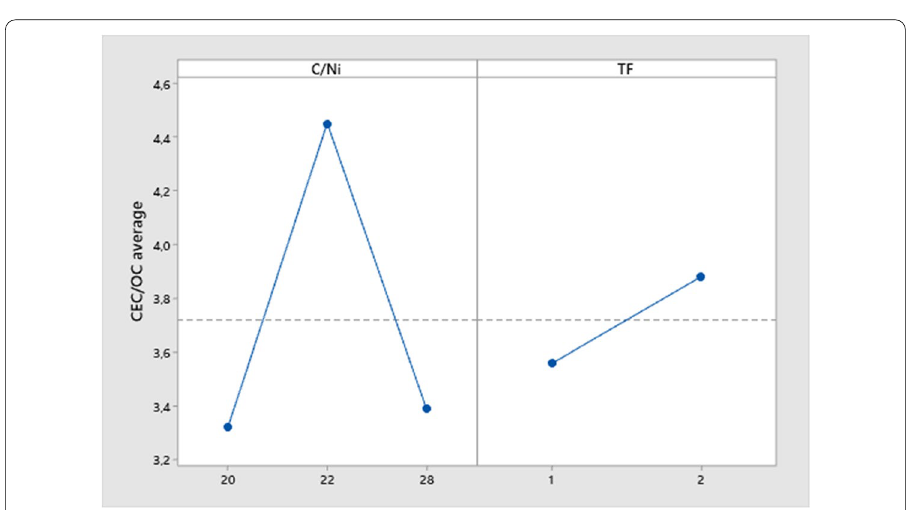
Fig. 13 Effect diagram of C/Ni and TF on